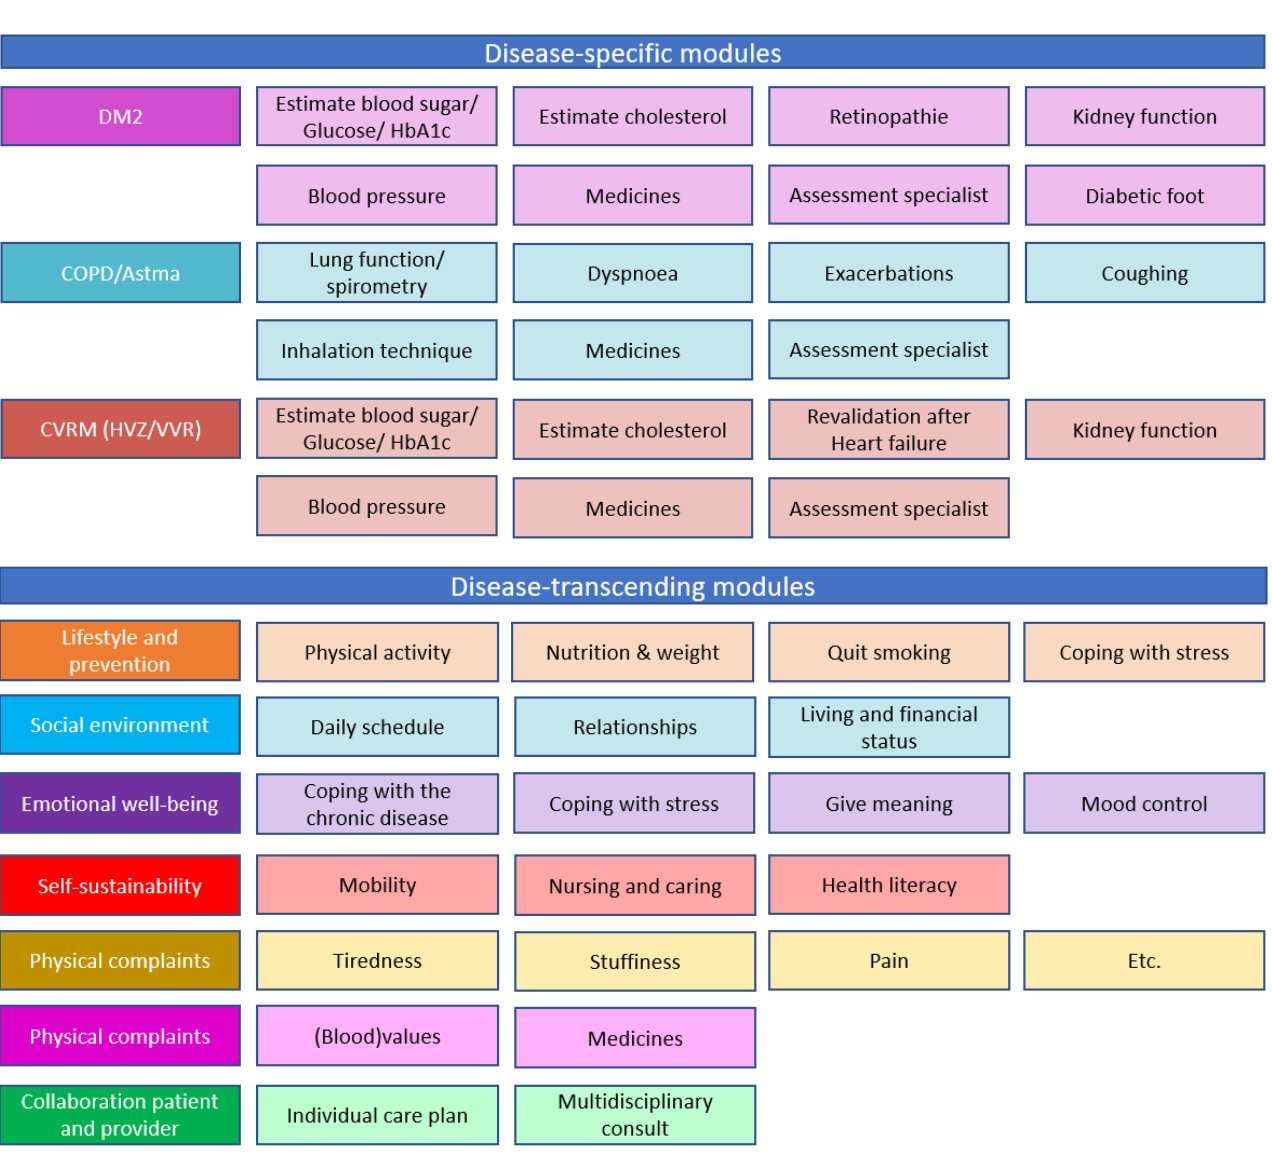
Figure 3. Disease-specific and disease-transcending modules provided through the new care plan and delivered if needed by the patient.